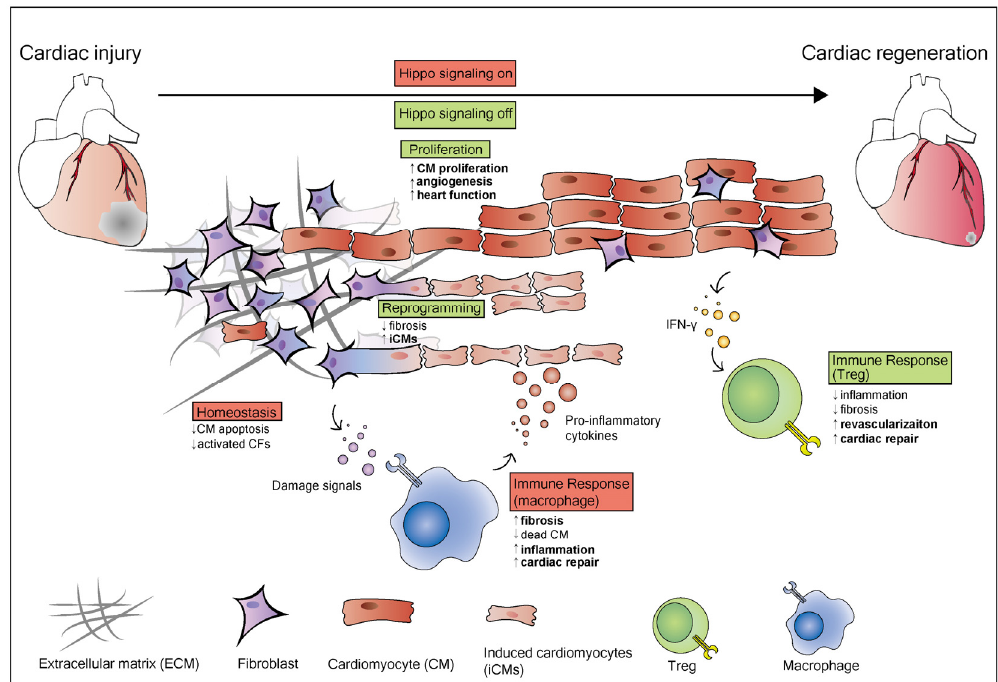
Figure 2. The role of the Hippo pathway in heart regeneration and homeostasis. The Hippo pathway plays di ff erent roles in di ff erent cardiac cell types. When Hippo signaling is on (shown in red), it maintains heart homeostasis and inhibits CM apoptosis and activated CFs. After an injury, the damaged area in the heart consists of dead cardiomyocytes, activated cardiac fibroblasts, extracellular matrix (ECM), and immune cells including macrophages and T-regulatory (Treg) cells. When the heart is injured, the homeostasis of the heart is destroyed. Damage signals induce an immune response that activates resident macrophages, which release pro-inflammatory cytokines to induce inflammation and fibrosis. Resting cardiac fibroblasts induced into activated CFs and myofibroblasts, then activate CFs which promotes fibrosis in the damaged area. Cardiac fibroblasts activation also can be achieved through inhibition of the Hippo pathway. In cardiomyocytes, Yap activation induces cardiomyocytes to re-enter the cell cycle and proliferate when Hippo signaling is o ff (shown in green). YAP5SA overexpression promotes the generation of new cardiomyocytes and reorganizes chromatin accessibility to a proliferative fetal-like state. In epicardial cells, the Hippo pathway promotes the secretion of cytokines such as interferon- γ (IFN γ ), which recruits T-regulatory (Treg) cells. Treg cells inhibit inflammation and fibrosis, promote cardiac repair and revascularization.